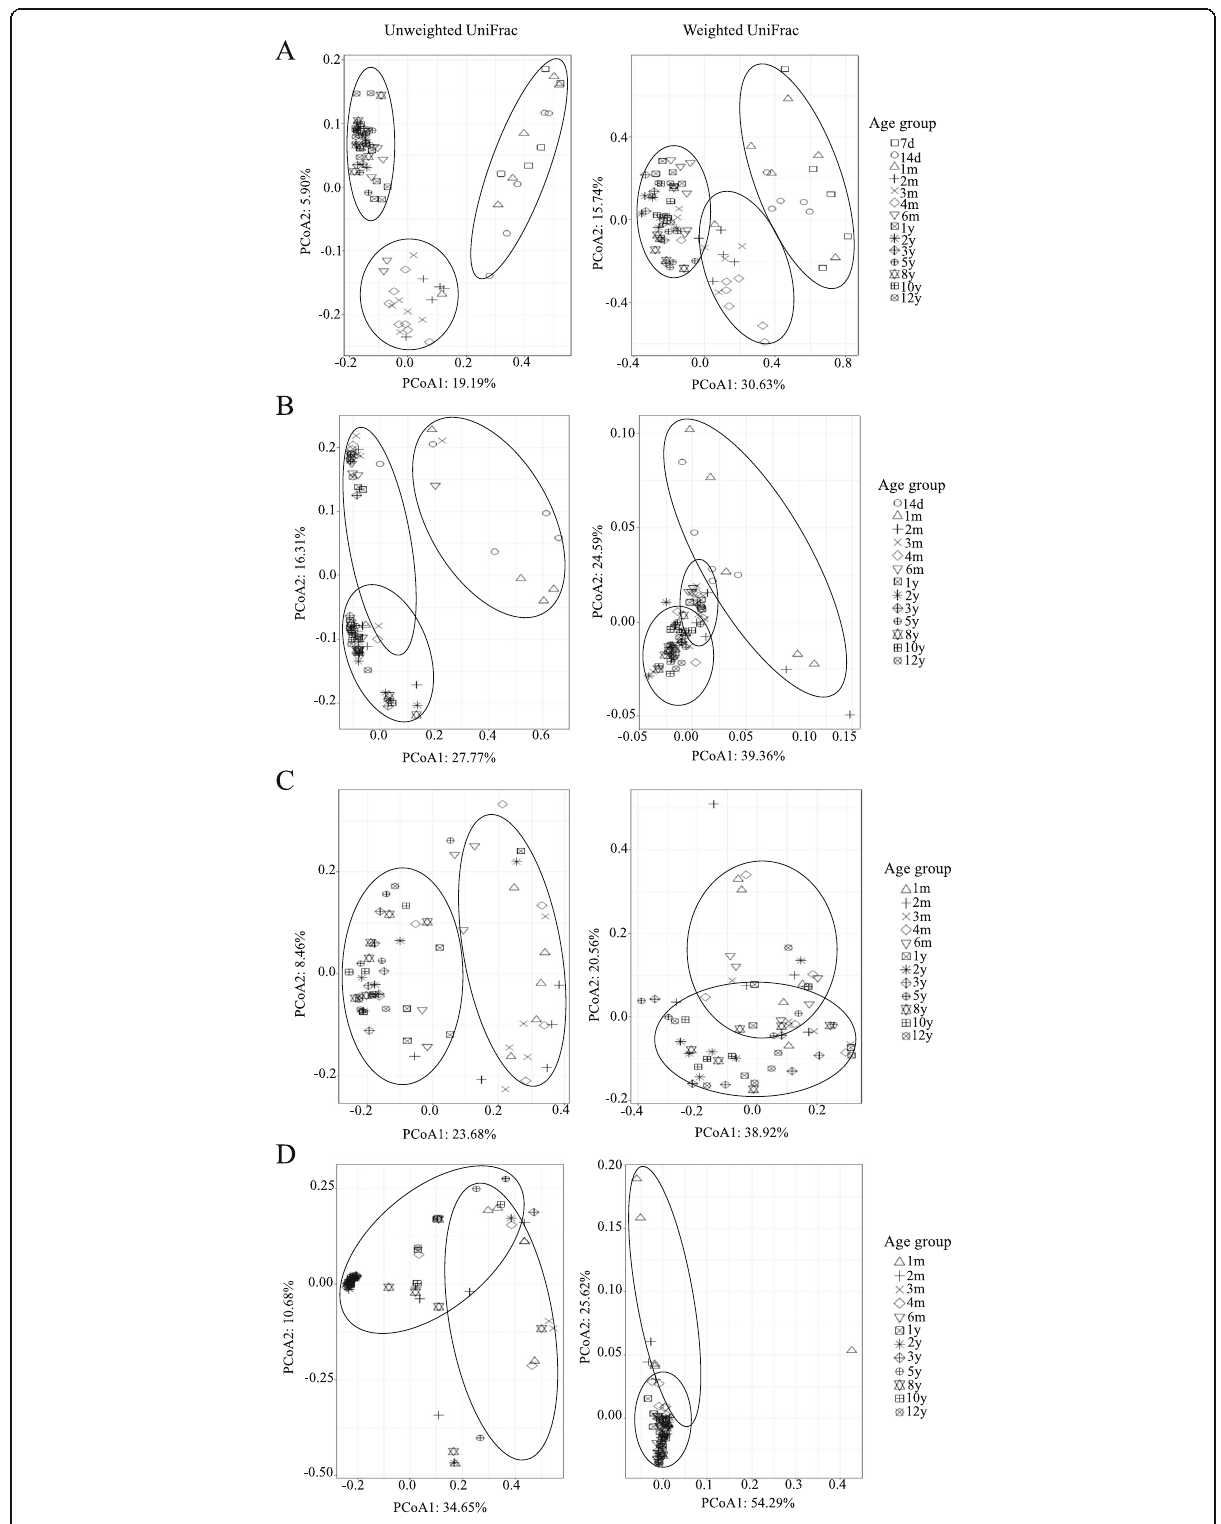
Fig. 3 Principal coordinate analysis (PCoA) based on weighted and unweighted UniFrac distances. Changes in the rumen bacterial ( a ), archaeal ( b ), fungal ( c ) and protozoal ( d ) community structure with growth